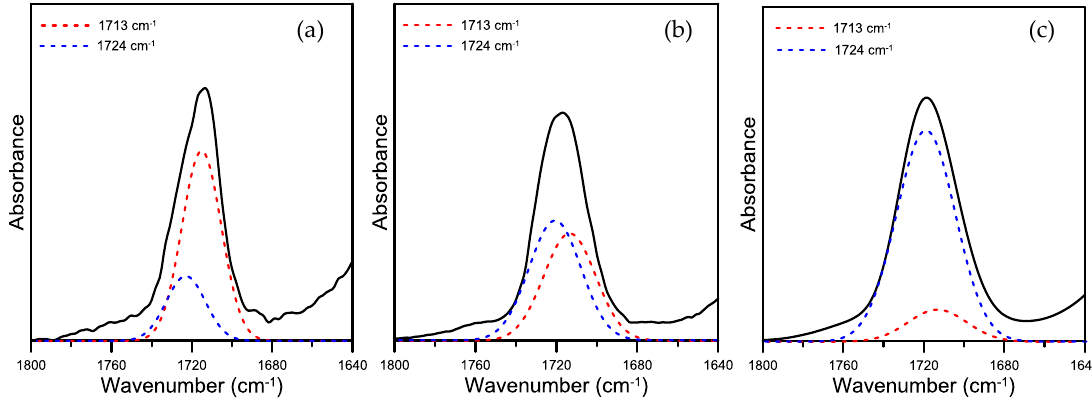
Figure 7. FTIR spectra of phenoxy/PBT (5/5) in the carbonyl absorption region for blends annealing at 260 °C for various periods of time. ( a) extracted solute and ( b ) eached solids. In each diagram, spectrum (I) 0, (II) 30, (III) 60, and (IV) 90 min, rspectively.